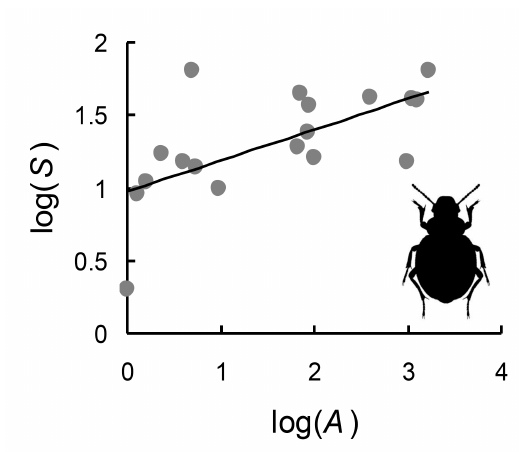
Figure 2. Species-area relationship (SAR) for tenebrionid species (total richness) in Italian reserves.